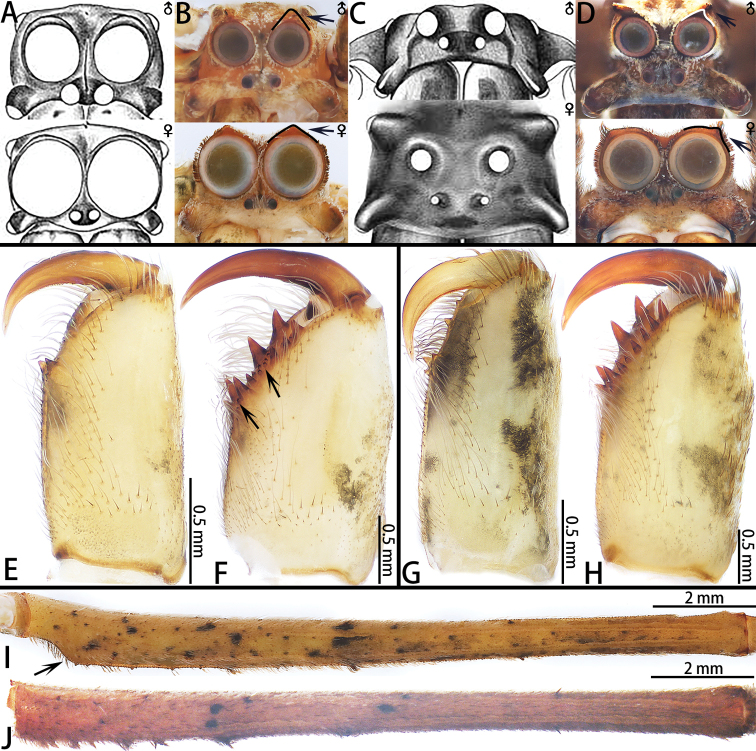
Prosoma (frontal view, upper ♂, lower ♀) (A–D), chelicerae (E–H) and leg I (I–J). Figures A and C modified from Coddington et al. (2012). ADeinopis
spinosaBAsianopis
liukuensis comb. nov. CMenneus
dromedariusDAsianopis
zhuanghaoyuni sp. nov. E Chelicerae of male A.
liukuensis comb. nov. F Chelicerae of female A.
liukuensis comb. nov. (Arrows indicate the denticles) G Chelicerae of male A.
zhuanghaoyuni sp. nov. H Chelicerae of female A.
zhuanghaoyuni sp. nov. I Left leg I of female A.
liukuensis comb. nov. Arrow shows enlarged femur J Left leg I of female A.
zhuanghaoyuni sp. nov.